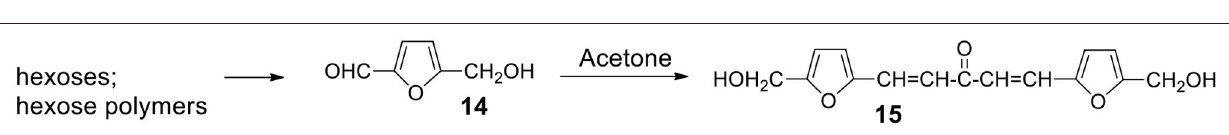
FIGURE 5 | Useful α , ω -diol deriving from condensation of acetone with 5-hydroxymethyl furfural 14 .